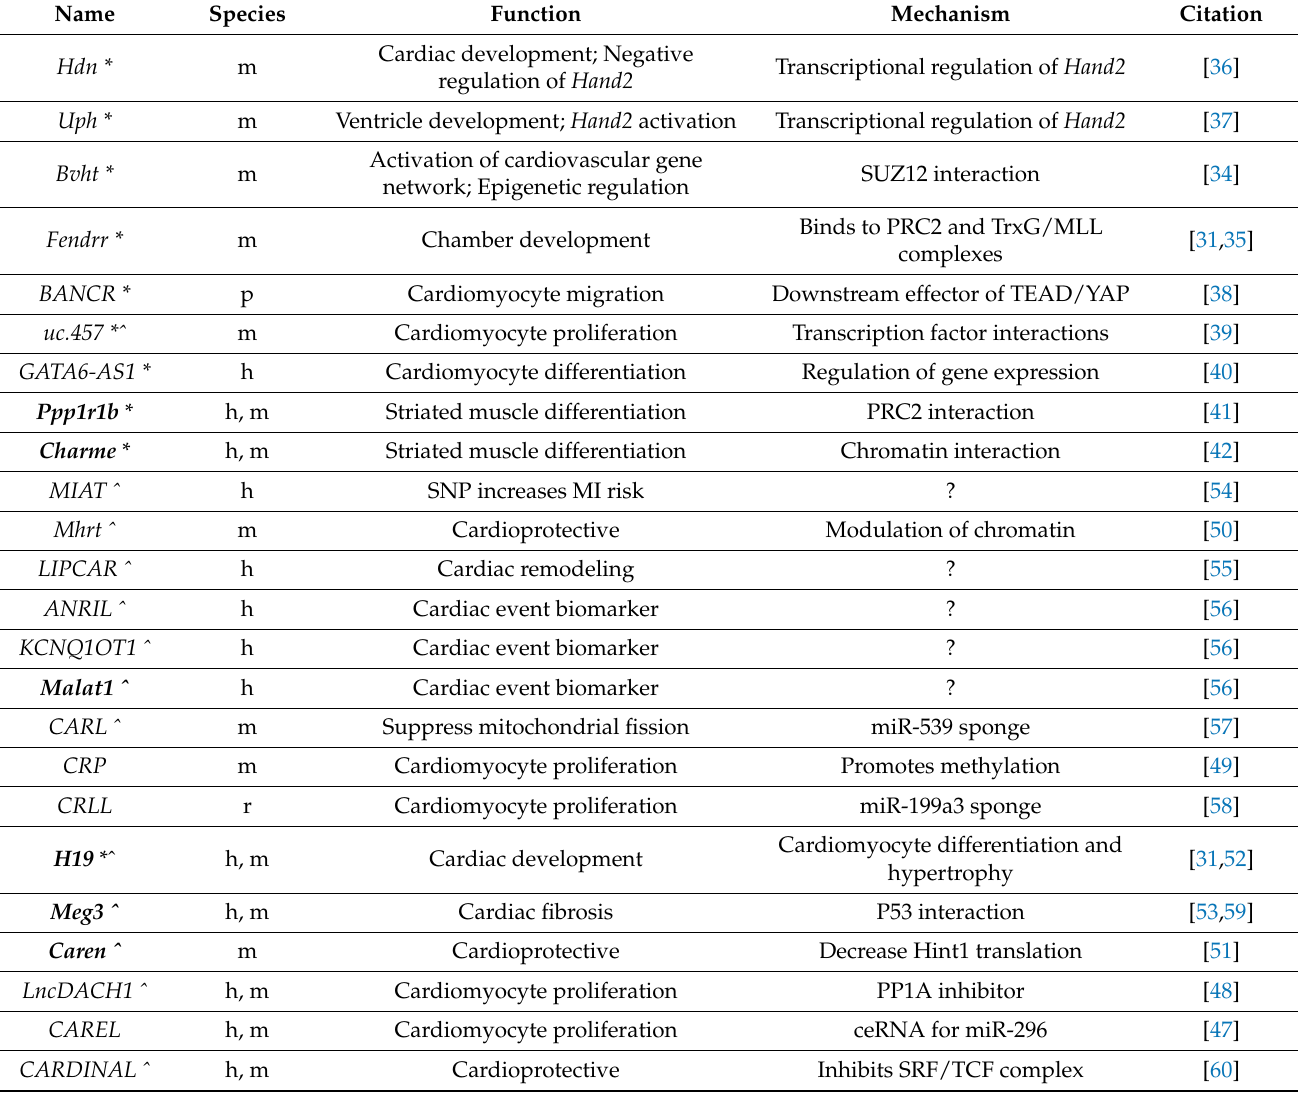
Table 1. Summary of key lncRNAs found in cardiac